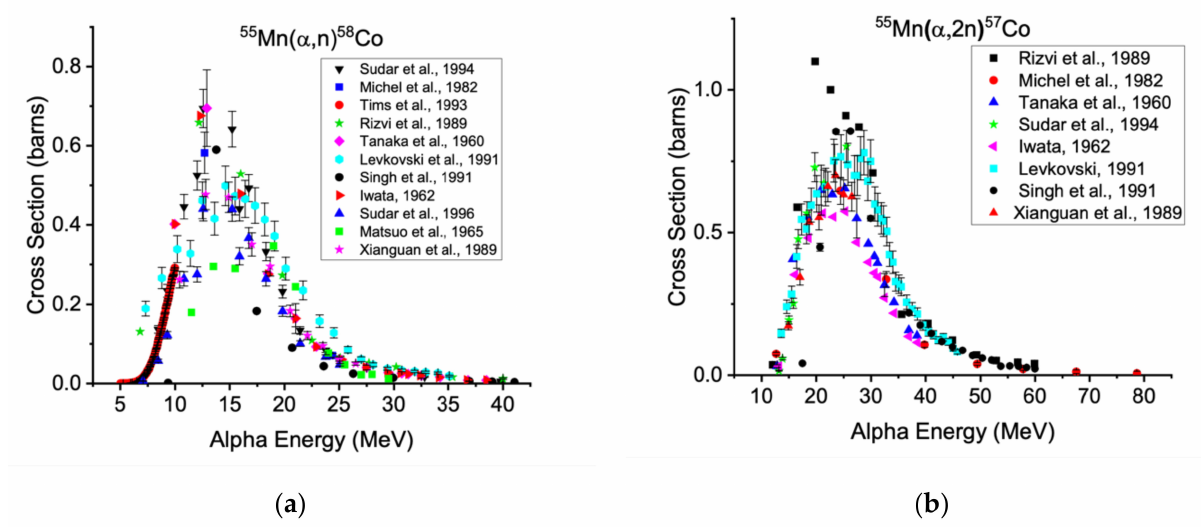
Figure 12. Excitation functions for the production of cobalt-58 from ( α ,n) reaction ( a ) and cobalt-57 ( b ) on manganese- 55 [29,30,32,35,78–84].